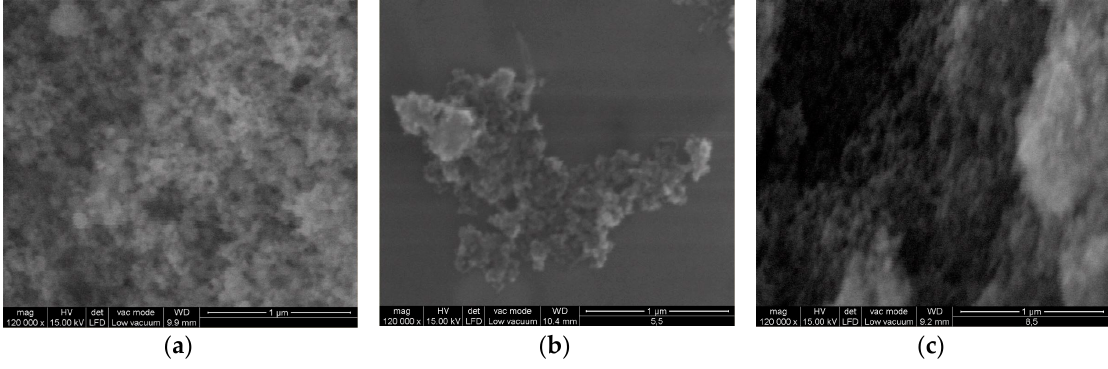
Figure 4. Scanning electron microscopy (SEM) images of P25 ( a ); TiO 2 -1% Fe–N, pH ~5.5 ( b ); and TiO 2 -1%-Fe–N, pH ~8.5 ( c ).